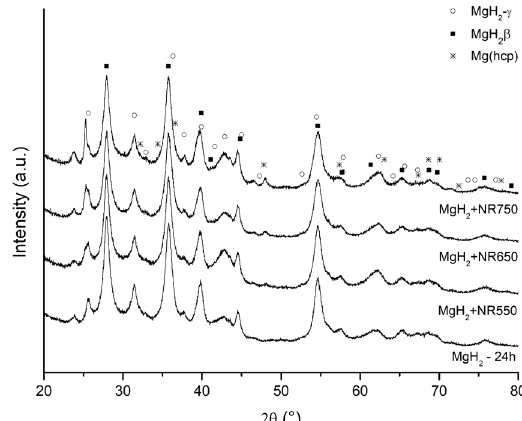
after milling for 24 h and 2 + 5 wt% of NR750, NR650 and NR550. 2